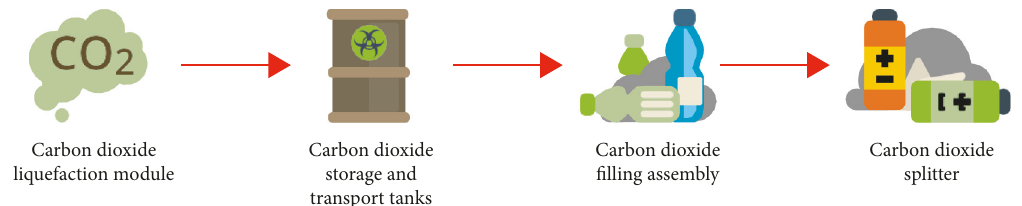
Figure 1: Air source protection